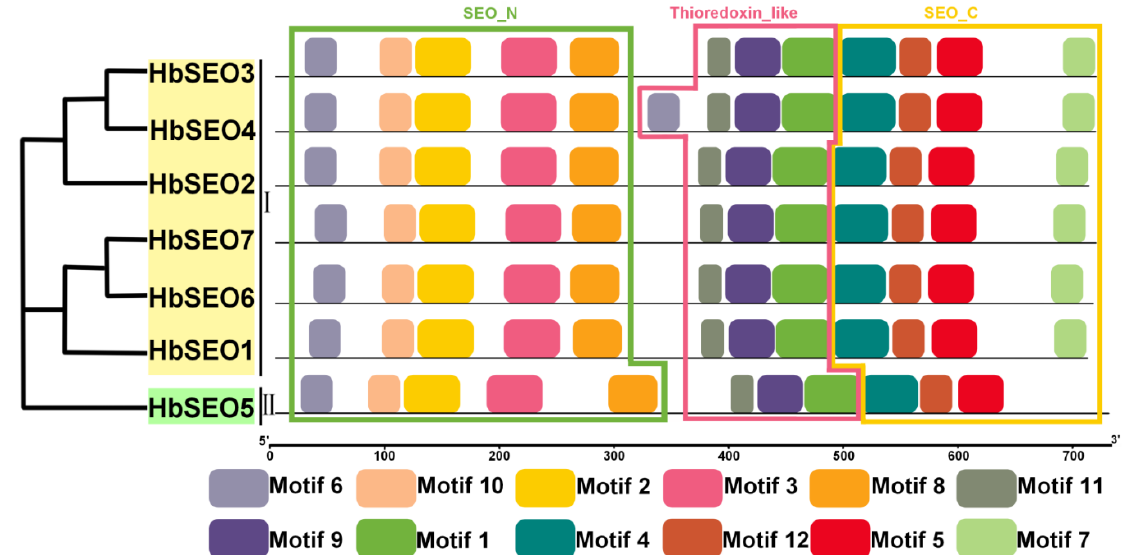
Figure 3. Gene structure of HbSEOs. The thick yellow boxes indicate CDS, the thick green boxes indicate UTR, and the black lines indicated introns.